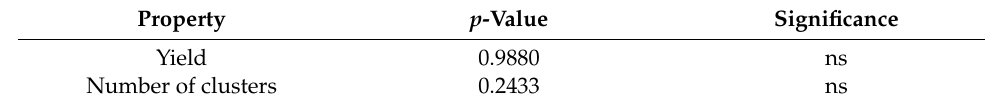
Table 3. Influence of foliar fertilization on yield and number of clusters.